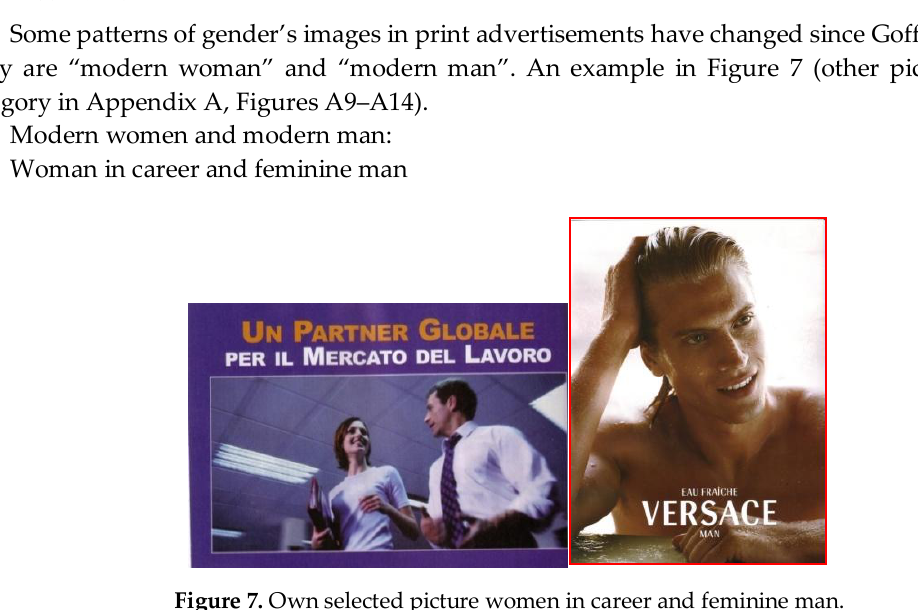
Figure 7. Own selected picture women in career and feminine man.